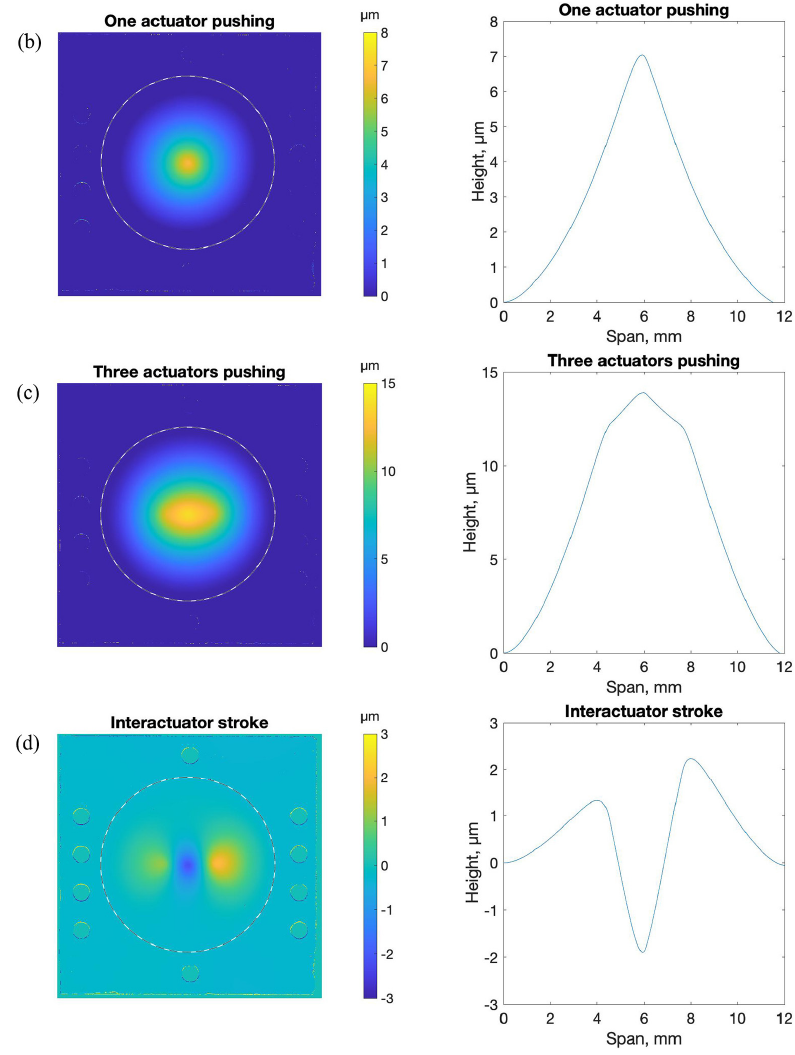
Figure 10. Measured topography due to electromagnetic actuation of a test device made with 10 µ m thick, 12 mm diameter face sheet supported by an array of 37 posts, with a magnet adhesively bonded to the distal end of each post. Actuation was achieved by driving current through one or more of three copper coils spaced 30 µ m from the base of three magnets near the center of the array. All topographic measurements are made by subtracting the measured topography from the static face sheet shape shown in the previous figure. Surface maps are shown on the left, with face sheet perimeter denoted by a dashed line. Horizontal profiles across the center of the map are shown on the right. ( a ) Center actuator energized to provide attractive force (pulling) at 500 mA current. Peak deflection ≈ 7 µ m. ( b ) Center actuator energized to provide repulsive force (pushing) at 500 mA current. Peak deflection ≈ 7 µ m. ( c ) Center three actuators energized to provide repulsive force (pushing) at 500 mA. Peak deflection ≈ 14 µ m. ( d ) Center actuator energized to provide attractive force (pulling) while neighbors are energized to provide repulsive force (pushing) 370 mA current. Inter-actuator stroke ≈ 4 µ m.